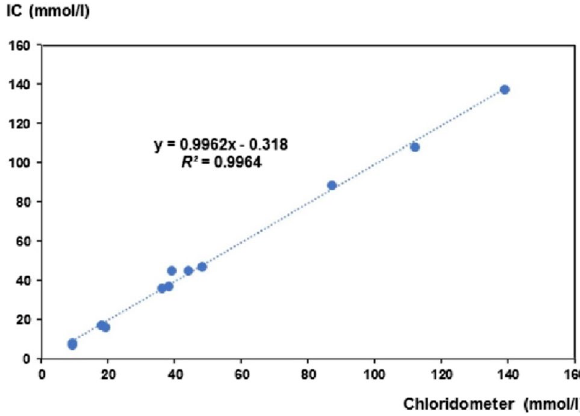
Fig. 2 Comparison of measured chloride concentrations measured by chloridometer and ion chromatography (n = 13)